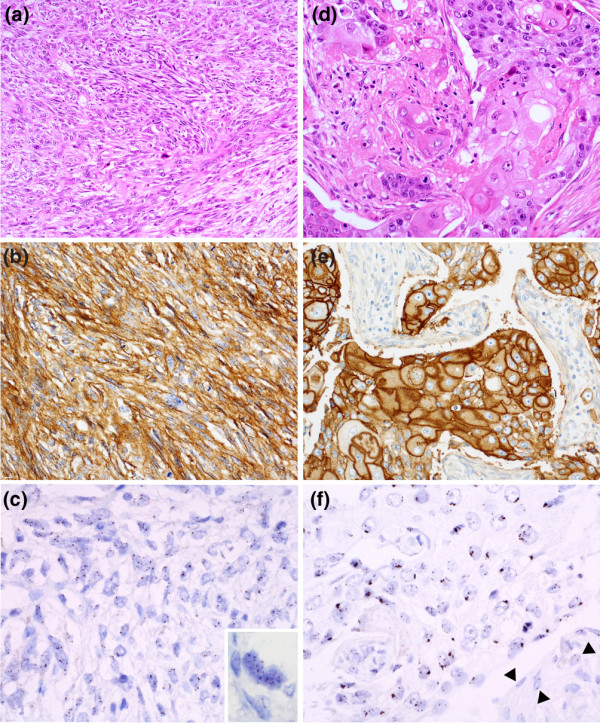
EGFR overexpression and gene amplification in MBCs. Photomicrographs of (a) a spindle cell metaplastic breast carcinoma (haematoxylin and eosin) showing (b) grade 3+ immunohistochemical positivity for EGFR and (c) EGFR gene amplification (>5 signals per nucleus [CISH]). Inset in panel c: note the bizarre neoplastic cell with more than 10 copies of EGFR. (d) Breast carcinoma with squamous metaplasia (haematoxylin and eosin) with (e) EGFR grade 3+ immunohistochemical positivity. (f) CISH demonstrating EGFR amplification (clusters of signals in the nuclei of neoplastic cells). Note the presence of one or two signals in the nuclei of stromal cells (arrowheads). CISH, chromogenic in situ hybridization; EGFR, epidermal growth factor receptor; MBC, metaplastic breast carcinoma.